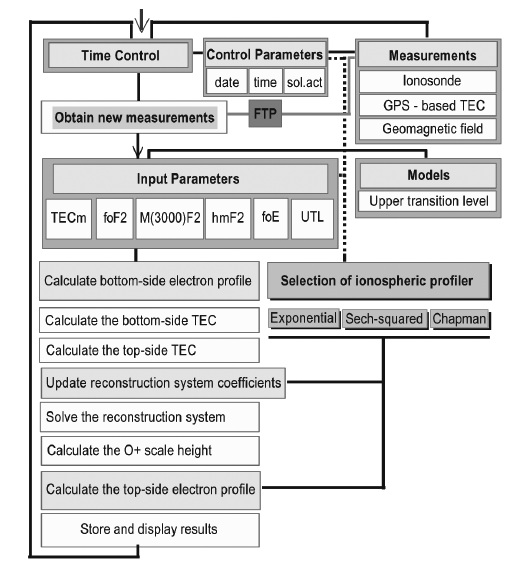
Fig. 3.4. Procedure for real-time reconstruction of the electron density